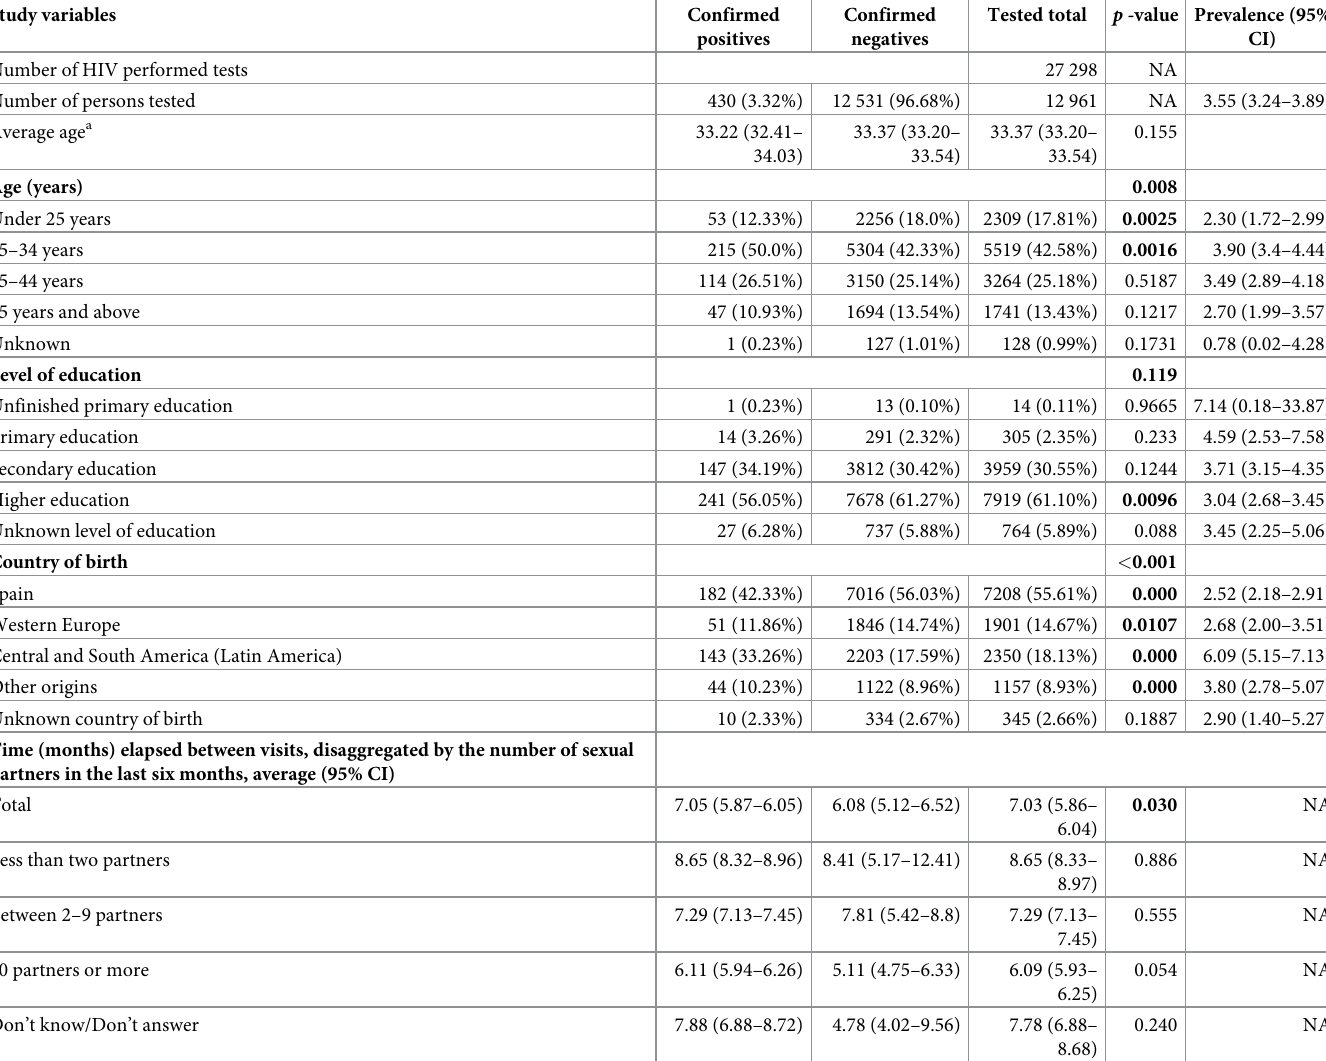
Table 1. Prevalence of HIV infection according to demographic features and time elapsed between visits in participants that got tested at BCN checkpoint, Spain (25 March 2016 to 24 March 2019). Study